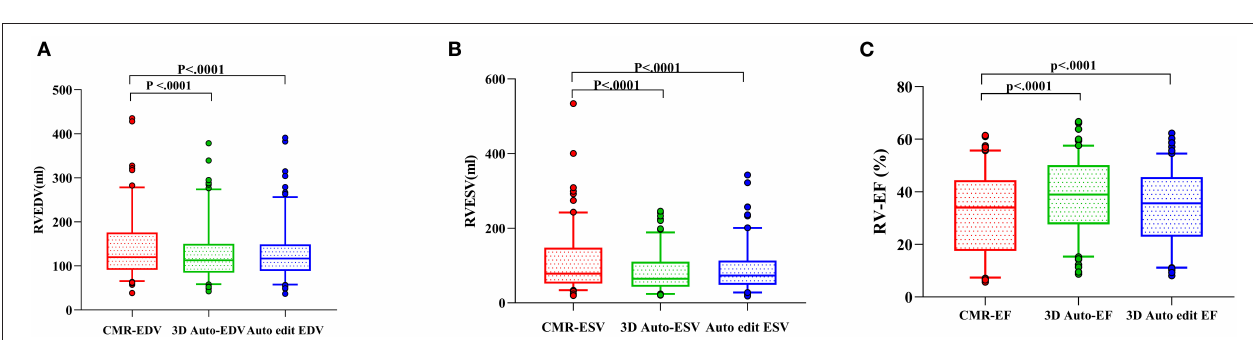
FIGURE 4 | RV measurements comparison among three methods [3D auto RV, manual editing method, and cardiac magnetic resonance (CMR)]. Right ventricular end-diastolic volume (RVEDV) (A) , right ventricular end-systolic volume (RVESV) (B) , and right ventricular ejection fraction (RVEF) (C)